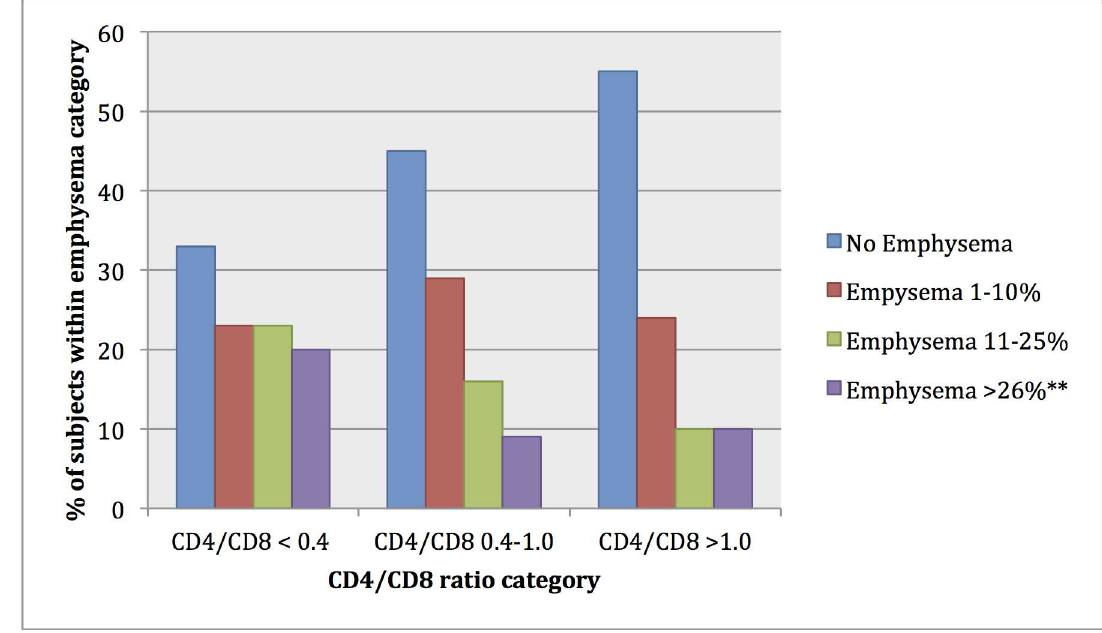
Fig 1. Severity of emphysema by CD4/CD8 ratio group (p = 0.02 for trend) * . * Cuzick’s test of trend ** Emphysema categories of 26–50%,51–75%and > 75% collapsedfor this graph given low numbersof subjects in higheremphysema